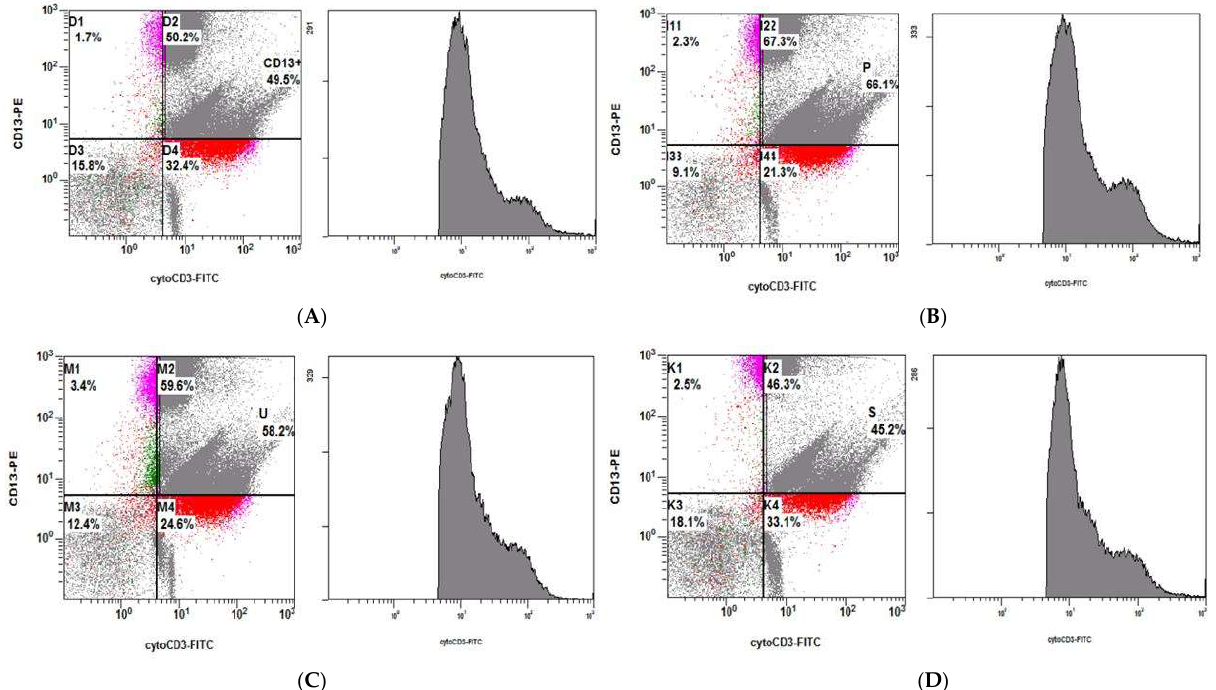
Figure 6. Necrotic Jurkat E6 cells were treated at −80 °C for 30 min and co-cultured with ( A ) shRNA2- MATR3 KD THP1 cells; ( B ) shRNA4-MATR3 KD THP1 cells; ( C ) control vector transfected THP1 cells; ( D ) naïve THP1 cells. MATR3 KD THP1 cells had a higher ability to phagocytose necrotic Jurkat E6 cells. The y-axis represents the percentage of cytoCD3+CD13(+)/CD13(+) cells.